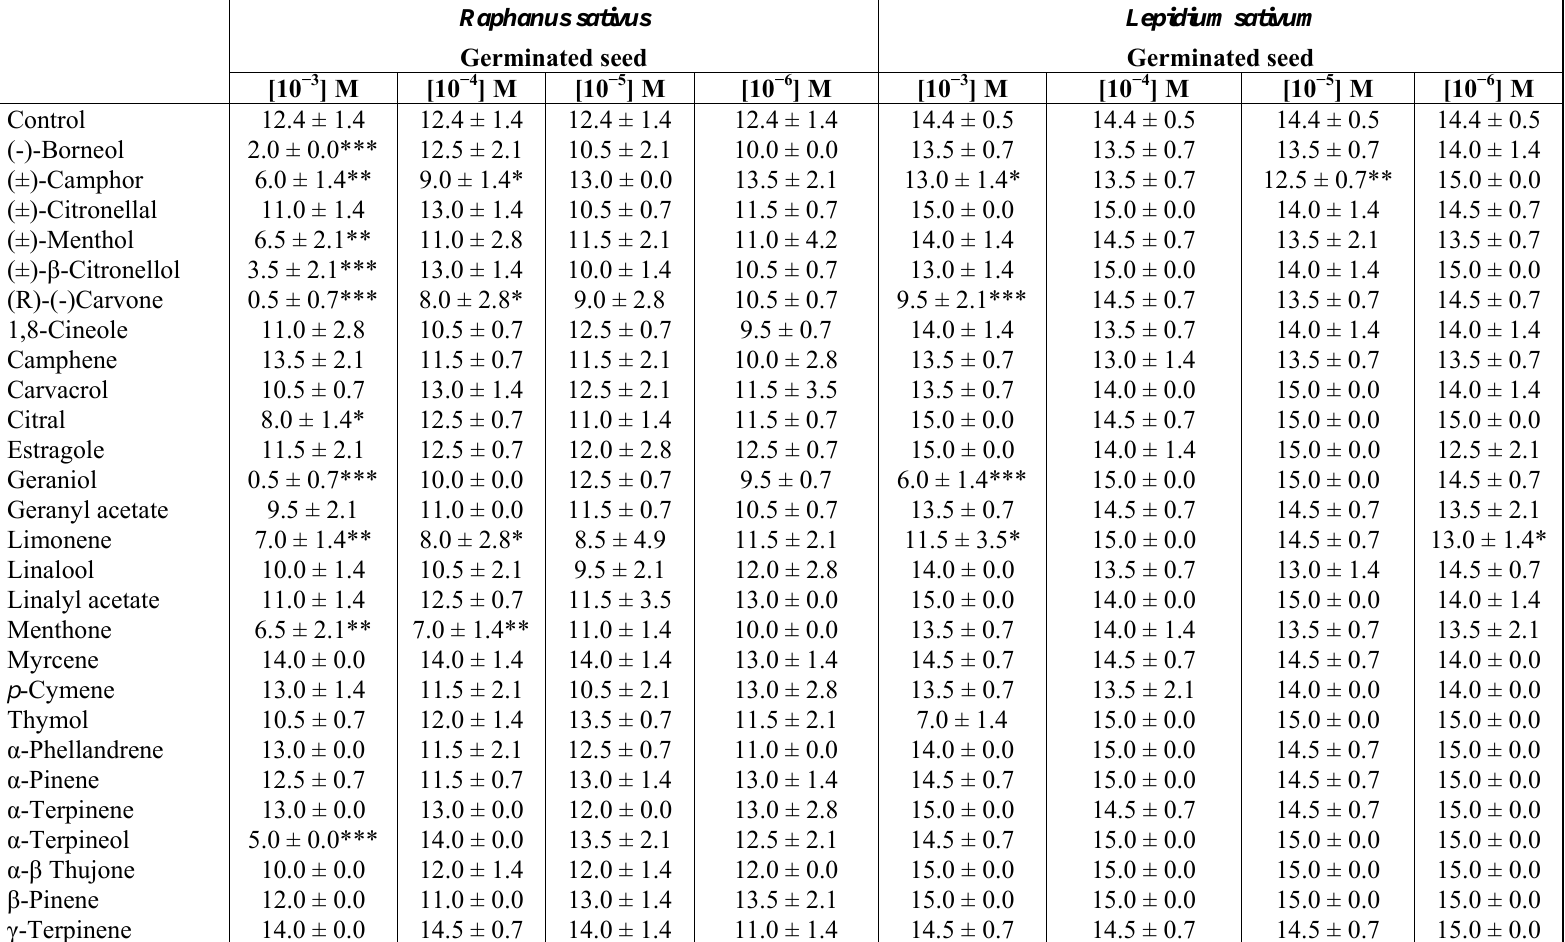
Table 1. Effects of different concentrations of monoterpenes on radish and garden cress germination, 120 hours after sowing. The data are expressed as the mean of three replicates ±